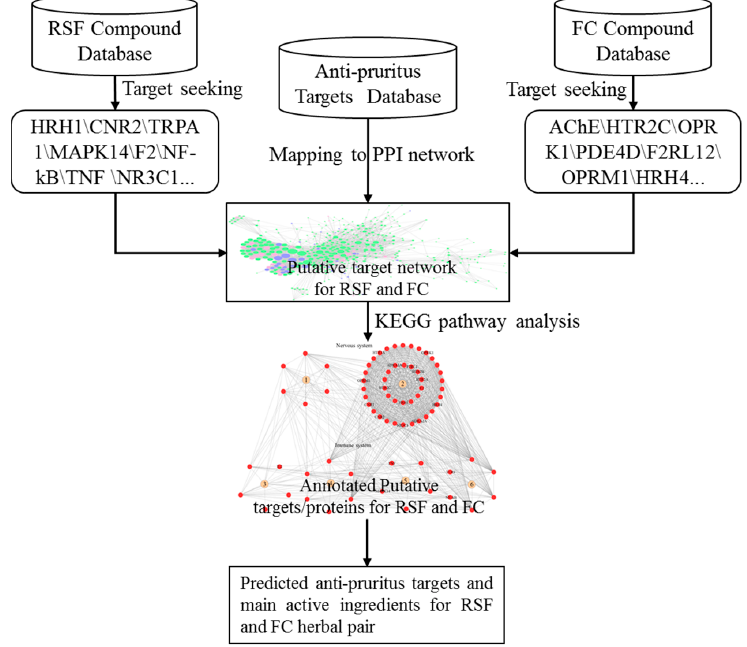
Figure 1. Flow chart for elucidating the mechanisms of action for the synergy of the RSF–FC herbal pair against pruritus.